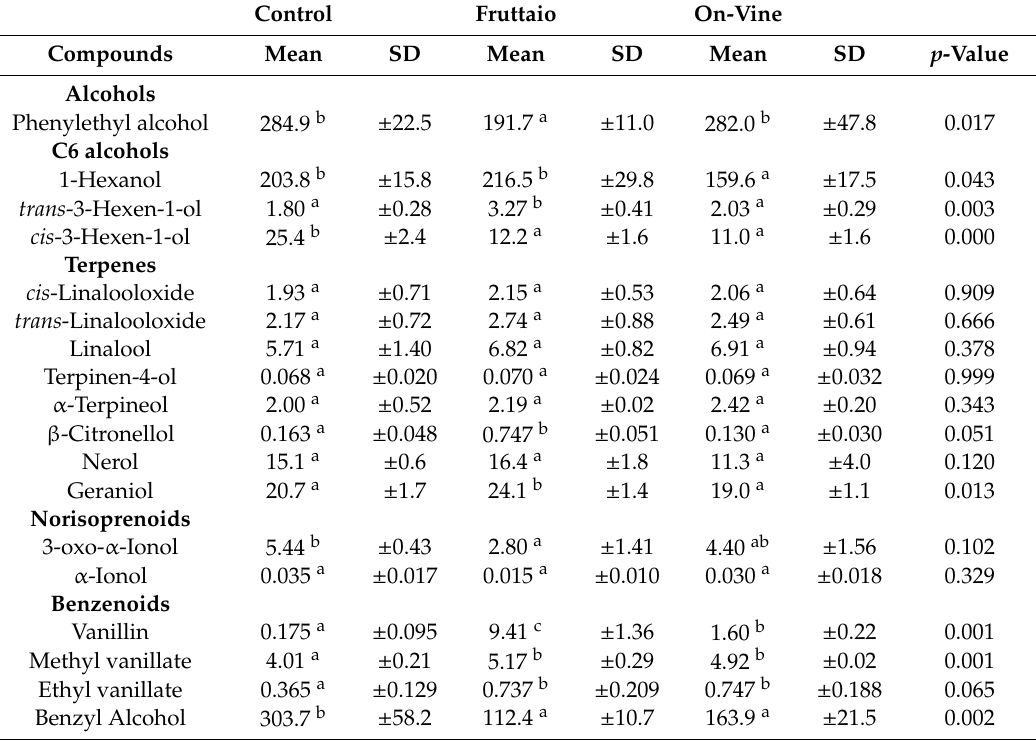
Table 2. Concentration ( µ g / L) of glycosidically-bound compounds in young wine samples. Mean, standard deviation (SD) and ANOVA.